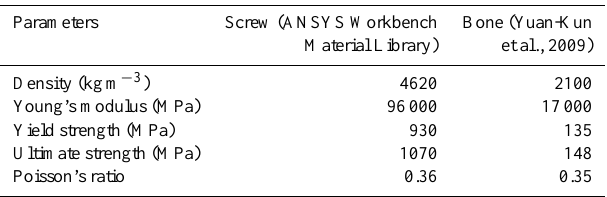
Figure 4. 3-D view of five different configurations for femoral neck fracture. Table 1. Mechanical properties of bone and screw used in the FEA (Yuan-Kun et al., 2009).